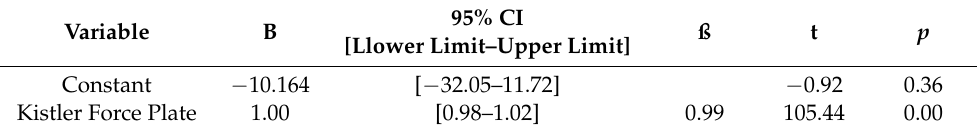
Table 2. Regression analysis summary for the validation of sensor-derived punch force determination.